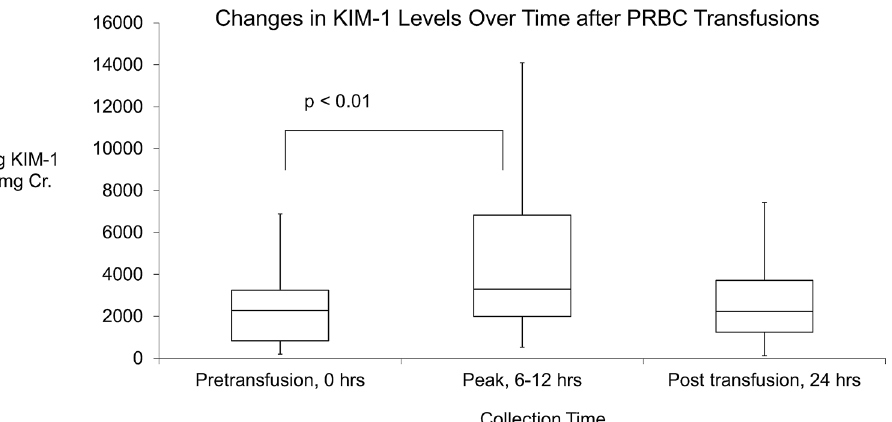
Figure 1. Changes in KIM-1 Levels with PRBC transfusions: KIM-1 levels were significantly higher 6 to 12 h after the transfusion but by 24 h had no significant difference from pretransfusion